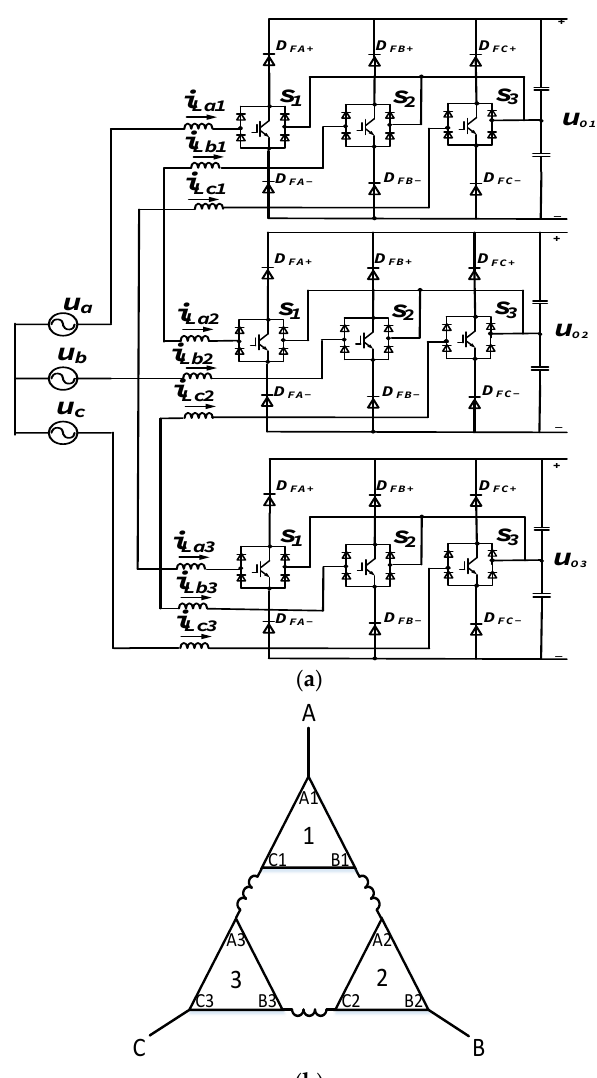
Figure 2. Triple line voltage cascaded VIENNA converter. ( a ) the schematic circuit diagram. ( b ) simplified connected structure